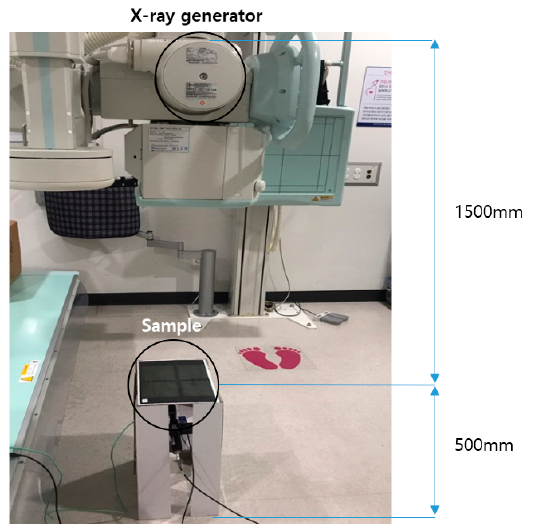
Figure 4. Experimental setup for evaluating the performance of the shielding fiber.